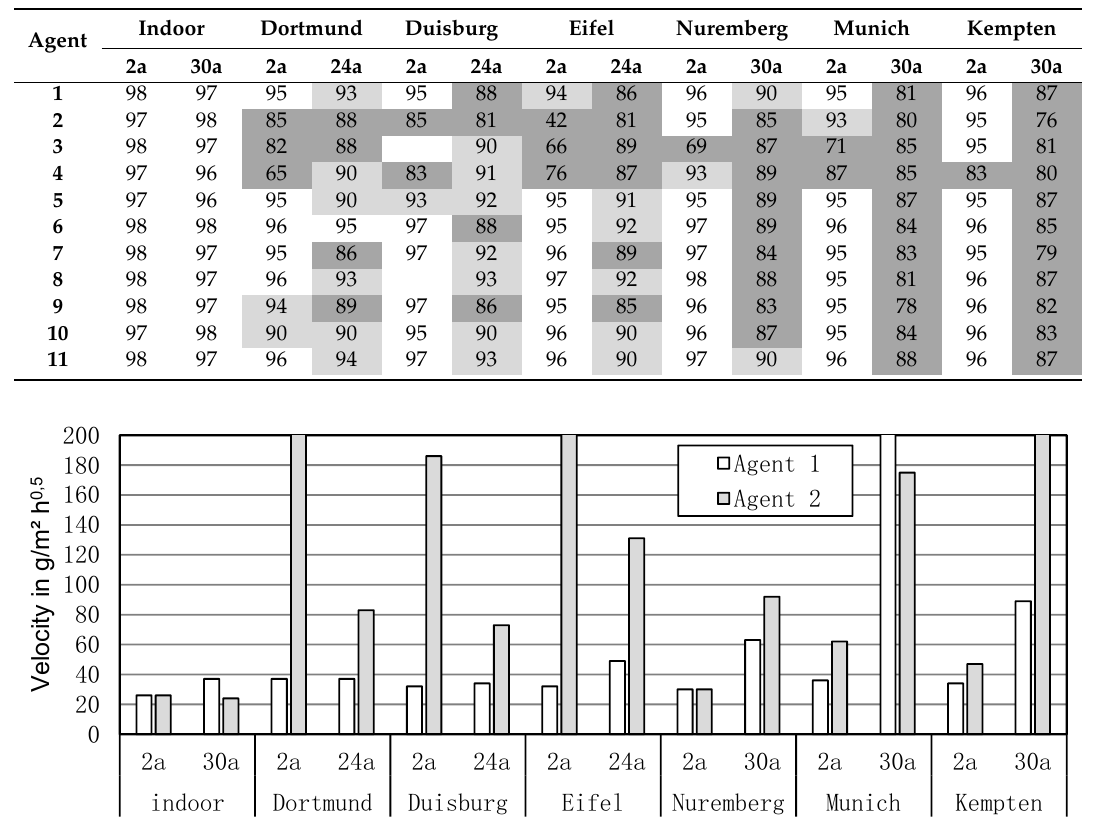
Table 6. Protection degree PD Ci calculated from capillary water absorption tests after a weathering time of 2, 24 and 30 years, respectively, at the 7 locations (PD classes: 100% to 95%: hydrophobic (white